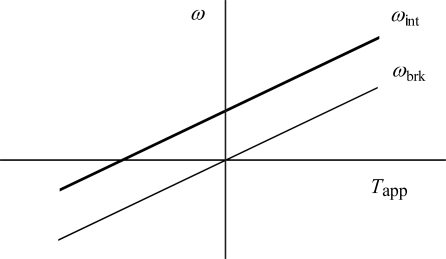
Schematic illustration of the effect of the externally applied torque Tapp on the cell rotation velocity ω for E. coli cell [19, 20]. The cell is tethered by a single flagellum and the cell body is rotated electrically. ωint and ωbrk are rotation velocities of the cell intact and the cell broken, respectively.